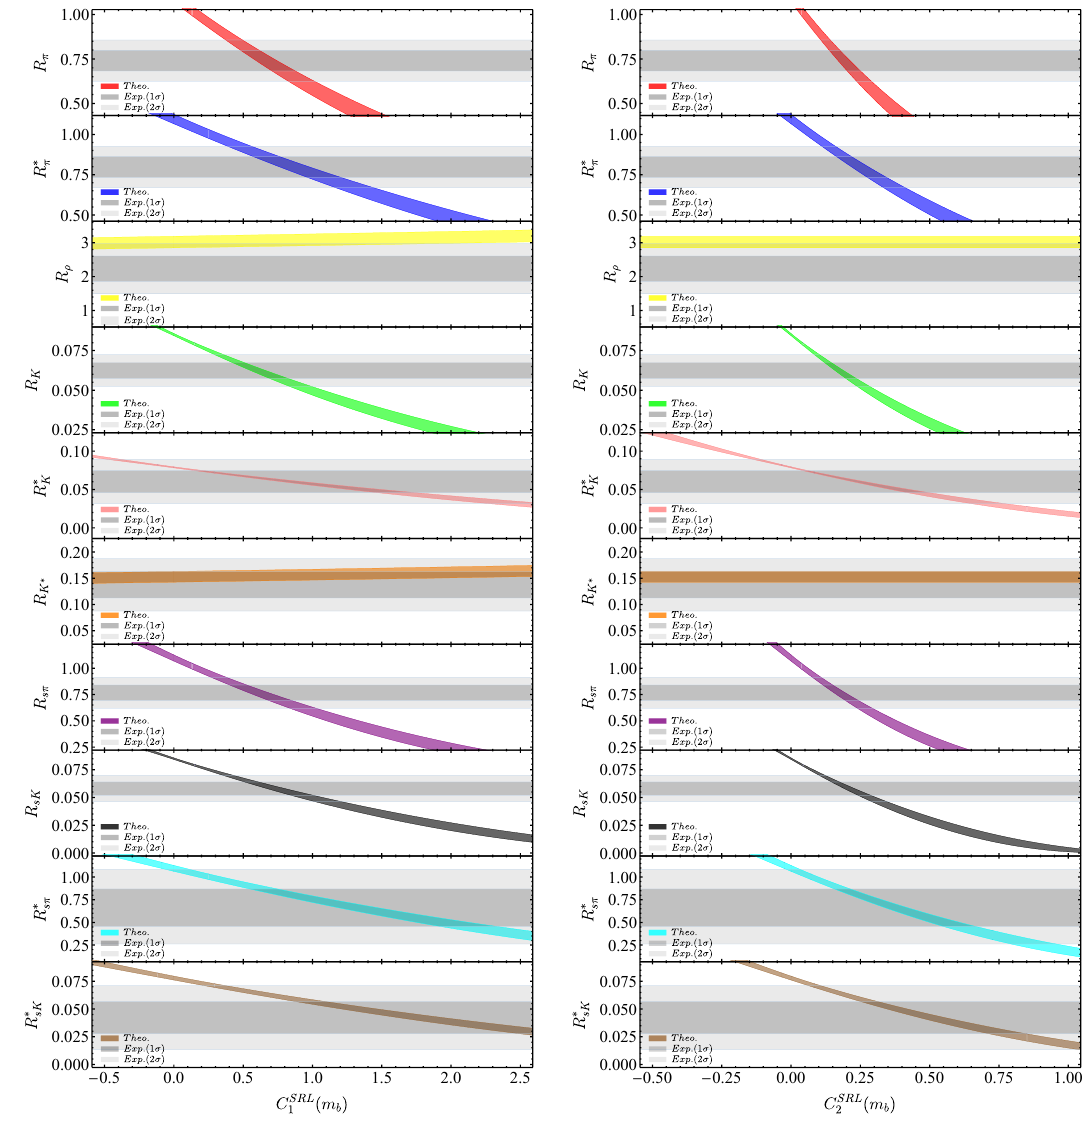
Figure 6 . Same as in figure 5 but for the NP Wilson coefficients C SRL